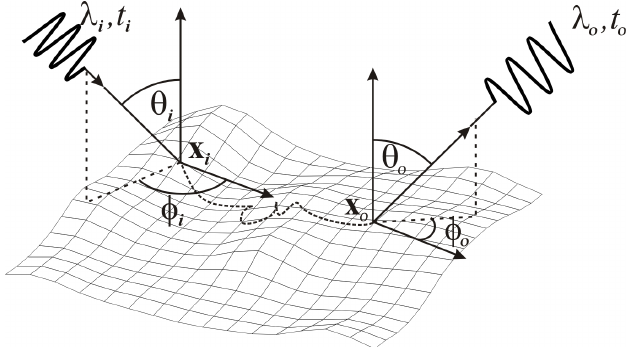
Figure 1. The parameters of the 12 -dimensional scattering function, enabling the description of light interaction with objects bounded by a surface. Image taken from